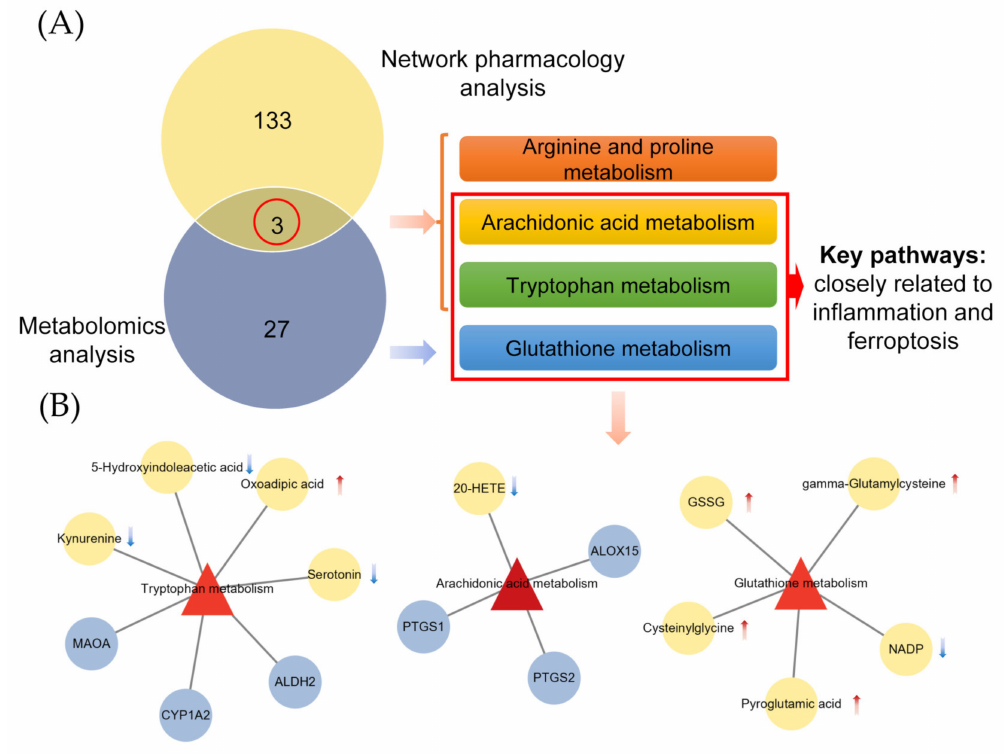
Figure 4. Combined analysis of metabolomics and network pharmacology. ( A ) The pathways co-enriched by metabolomics analysis and network pharmacology analysis. ( B ) Targets and metabo- lites enriched in key pathways (red triangles represent pathways, gray circles represent targets, yellow circles represent metabolites, red arrows represent up-regulated and blue arrows represent